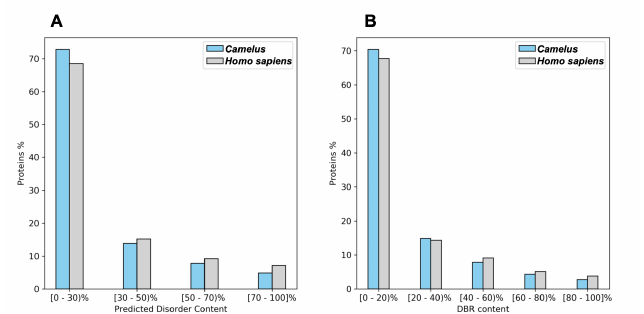
Figure 2. Binning of Camelus and Homo sapiens proteins by degree of ( A ) predicted disorder (percentage of disordered residues relative to sequence length, predicted by DISOPRED) and ( B ) disorder binding regions (predicted by